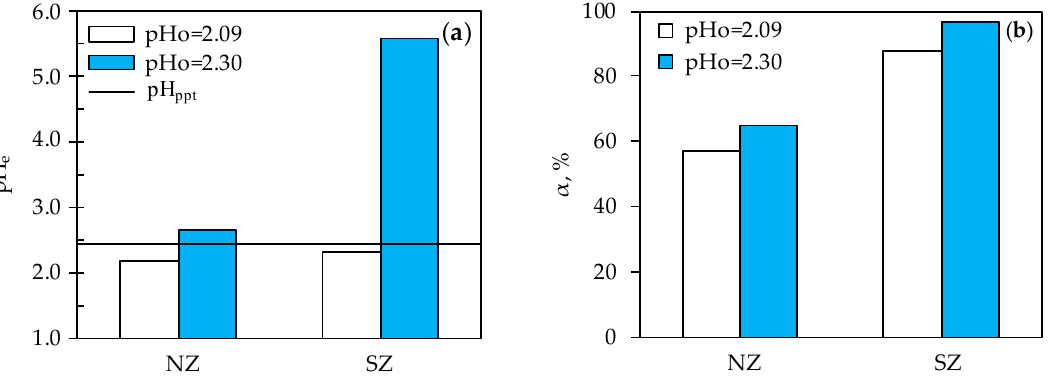
Figure 11. ( a ) pH ppt and pH e after sorption of Hg(II) onto NZ and SZ at pH o = 2.09 and 2.30. ( b ) Removal efficiency of Hg(II) for NZ and SZ at pH o = 2.09 and 2.30.